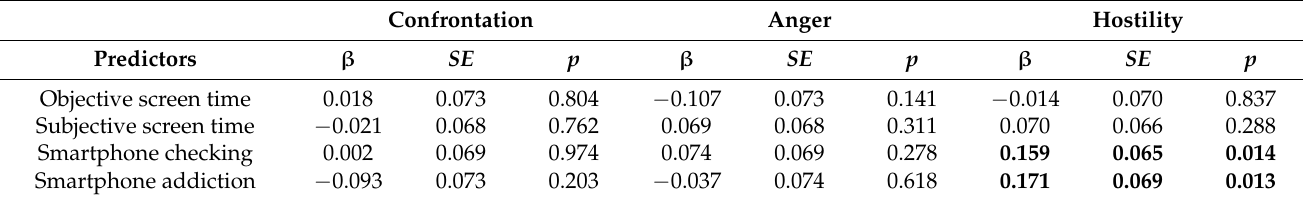
Table 4. Path Coefficients for Adjusted Structural Models with